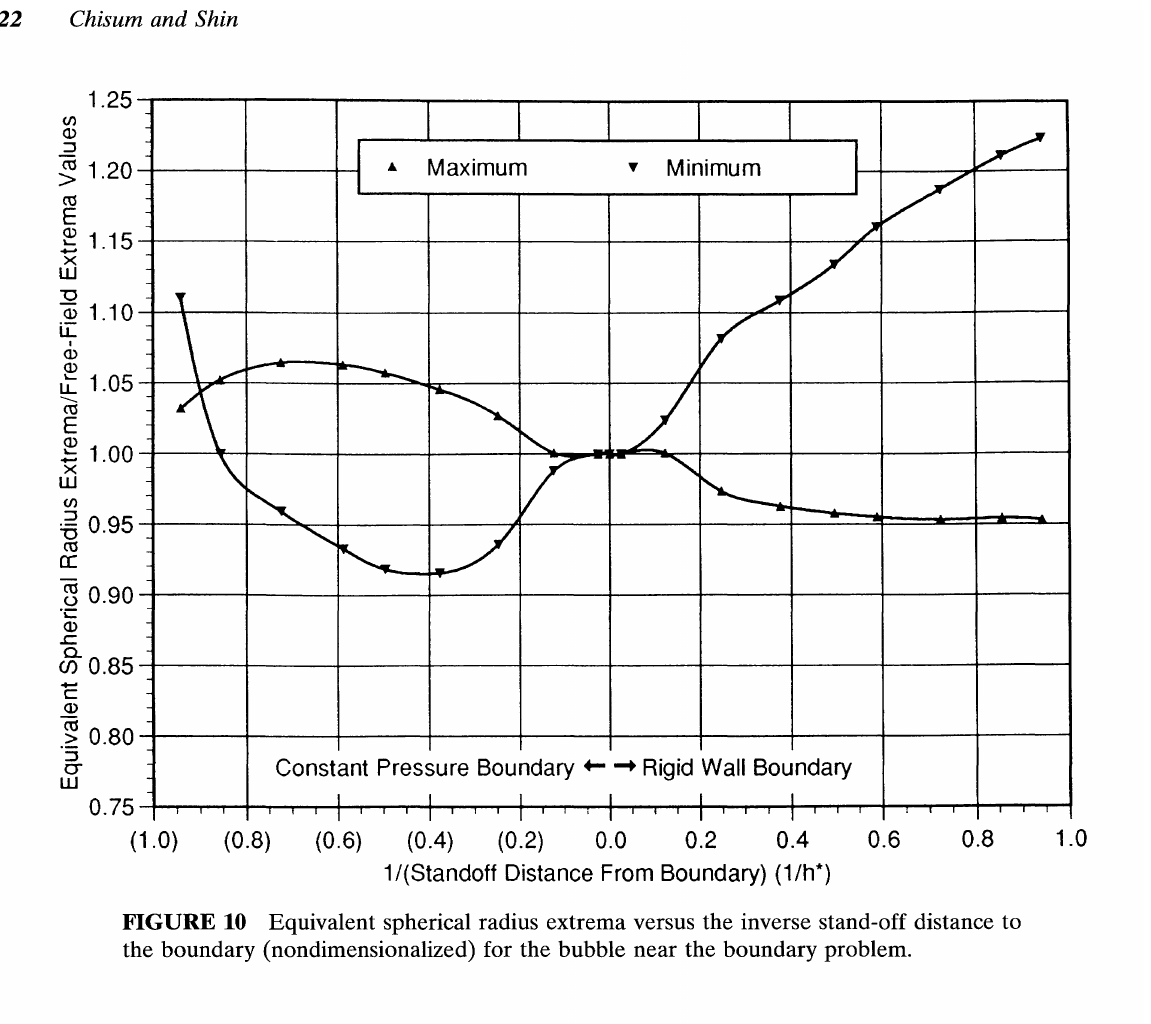
FIGURE 10 Equivalent spherical radius extrema versus the inverse stand-off distance to the boundary (nondimensionalized) for the bubble near the boundary